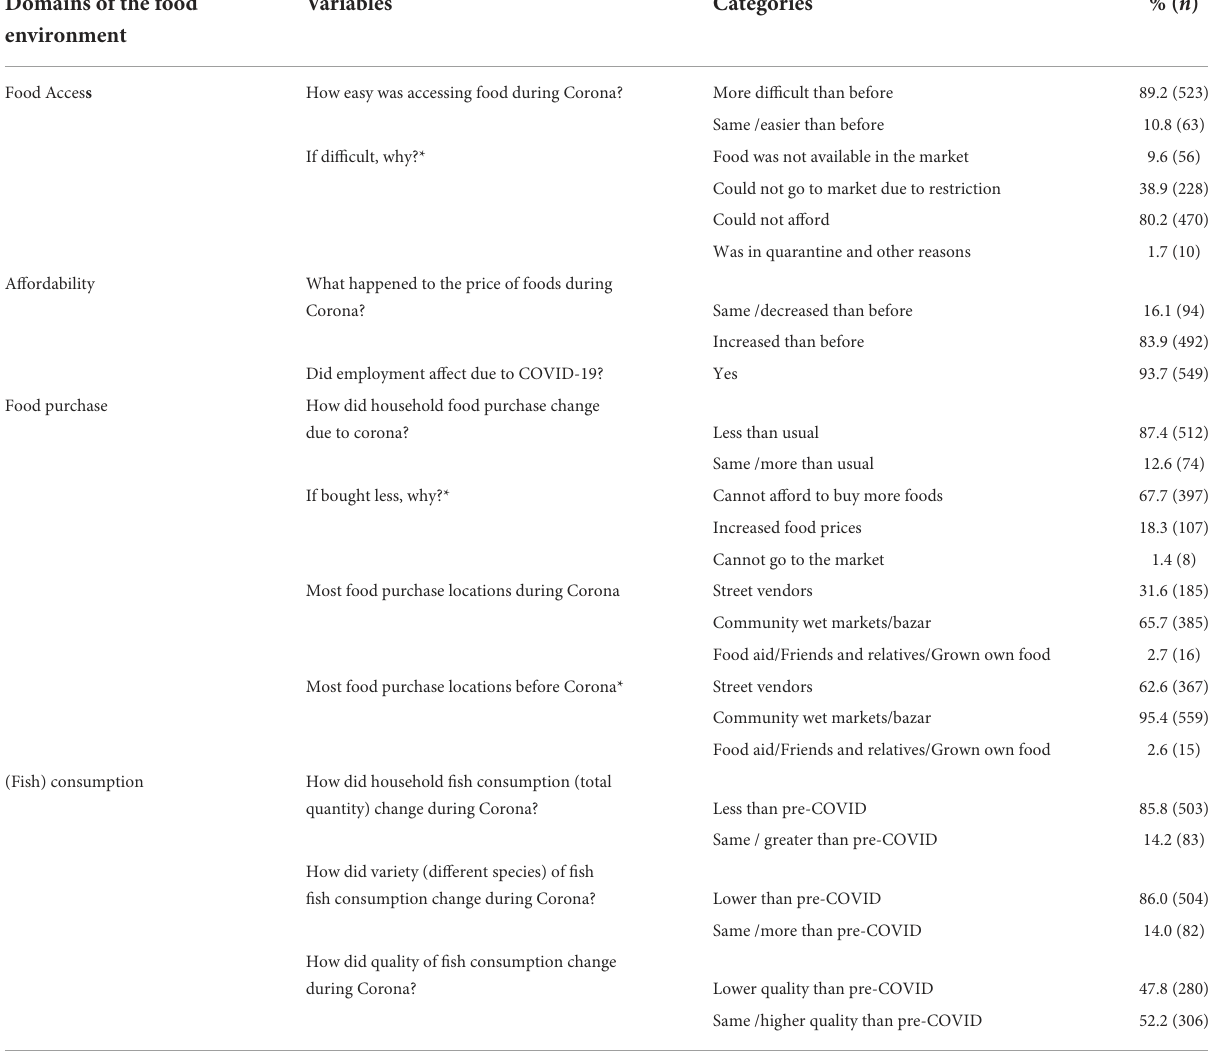
TABLE 2 Changes in the food environment, food purchase, and fish consumption among the low-income urban households ( n = 586) during the first wave of the COVID-19 pandemic in Bangladesh. Domains of the